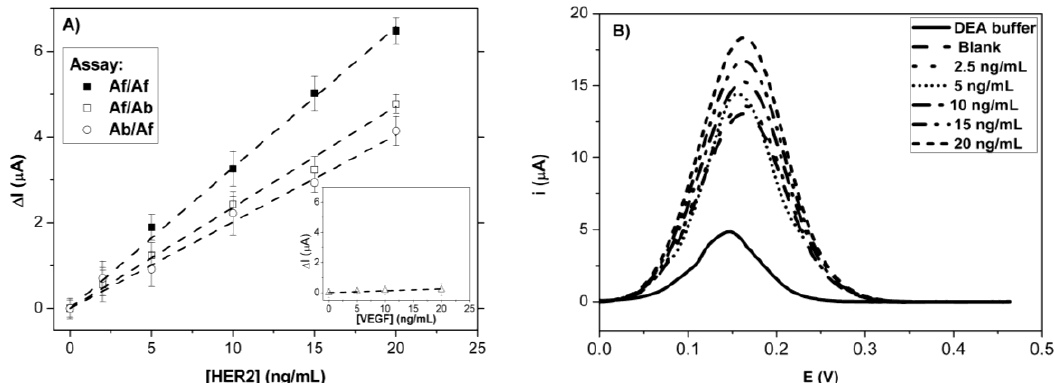
Figure 1. ( A ) Calibration curves for HER2 protein obtained using affibody/affibody (Af/Af), affibody/antibody (Af/Ab) and antibody/affibody (Ab/Af)-based assays. Inset: nonspecific interaction evaluation with vascular endothelial growth factor (VEGF) protein; ( B ) Differential pulse voltammetry (DPV) scans of Af/Af assay. Blank signal was subtracted from each measurement. Electrochemical measurements were performed in accordance with Section 2.3.5. Each measurement was repeated at least 10 times using different screen-printed sensors.